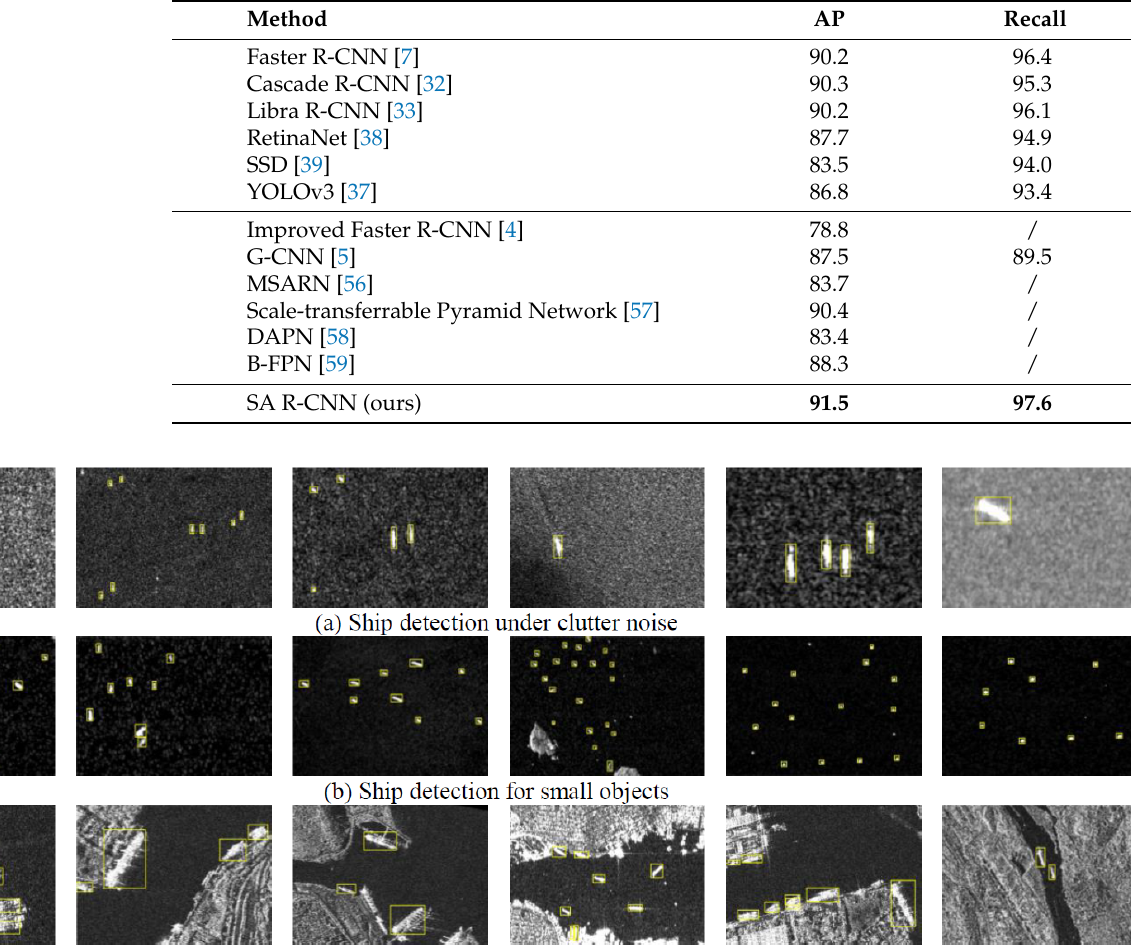
Table 6. Detection performance comparison on SSDD.